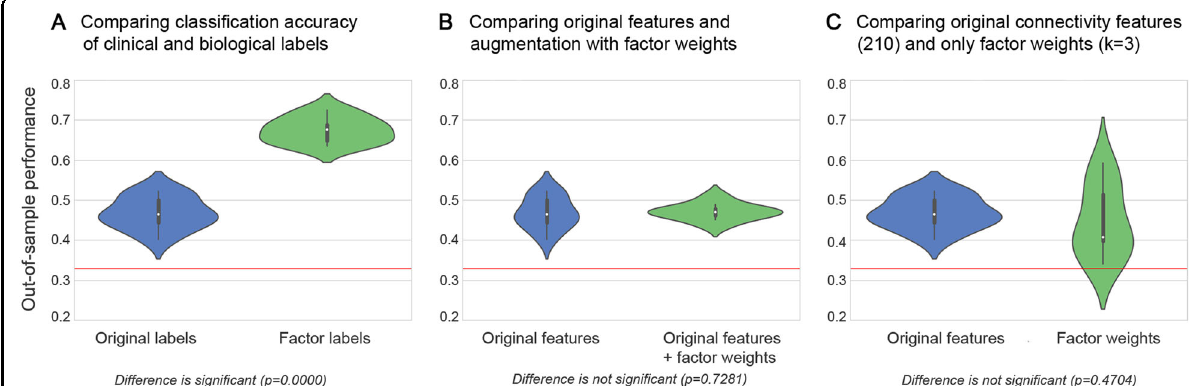
Fig. 5 Evaluation of predictability, robustness, and expressiveness of the transdiagnostic brain phenotypes for clinical validation. Evaluating intra-subject predictions, the clinical usefulness of the measured network connectivity strengths (blue) was systematically evaluated against the discovered neurobiological endo-phenotypes (green). Violin plots are similar to box plots in showing the median (white point), quartiles (thick black lines), and outliers (below/above thin black whiskers), but also expose the probability densities of the data points (sideways shapes). a Classi fi cation performance (1.0 = all subjects correct, 0.33 = chance as red line) of predicting the original diagnosis groups (TD, ADHD, and ASD) versus the neurobiologically derived groups (indicated by the most important factor in each participant) based on the overall brain connectivity. The data-derived disease factors could be much better predicted in connectivity pro fi les from new, previously unseen participants ( p < 0.0001). b Classi fi cation performance of predicting the original diagnosis groups based on connectivity pro fi les versus connectivity pro fi les and additional factor weights. Knowledge of the brain-derived disease factors much decreased the variance (concentration around medium), thus decreasing the uncertainty of each prediction for a given participant. c Group prediction performance from full connectivity pro fi le versus exclusive knowledge of the brain-derived factor weights. Without direct access to the original brain connectivity measurements, three factor weights summarizing each subject were suf fi cient for non-inferior prediction ( p = 0.47). The brain-imaging-derived phenotypes hence improved predictability, robustness,